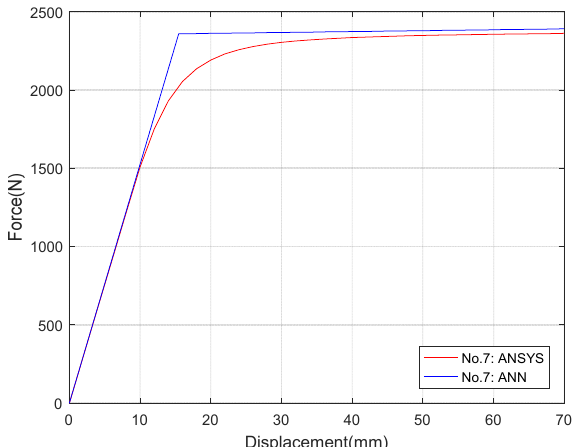
Figure 18. Estimated load–displacement curve (fifth coil damper).